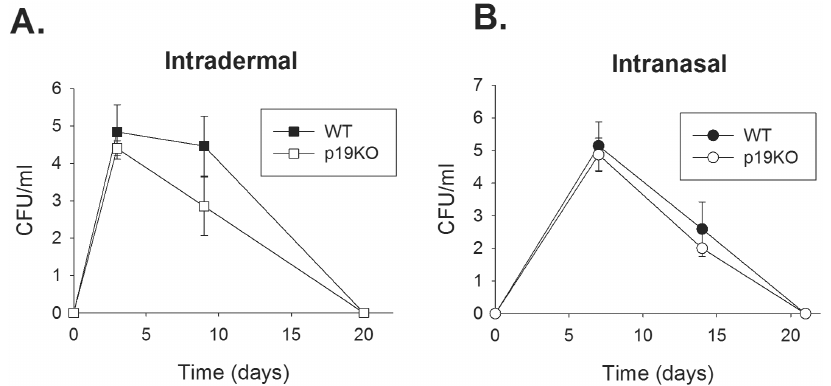
Figure 2. Bacterial burdens in tissues are comparable between infected WT mice and p19G KO mice infected with LVS ID and IN. Groups of 3 WT mice or p19G KO mice were infected either ID with 10 5 LVS (A), or were anesthetized and infected with 2 6 10 3 LVS IN (B). Mice were sacrificed at the indicated time points, and lungs, livers, and spleens plated to enumerate CFU. There were no significant differences in organ burdens between WT mice and p19G KO mice for any organ at any time point. Results shown are representative of two experiments of similar design and outcome. p19M KO mice were also included in one experiment with similar results (data not shown).